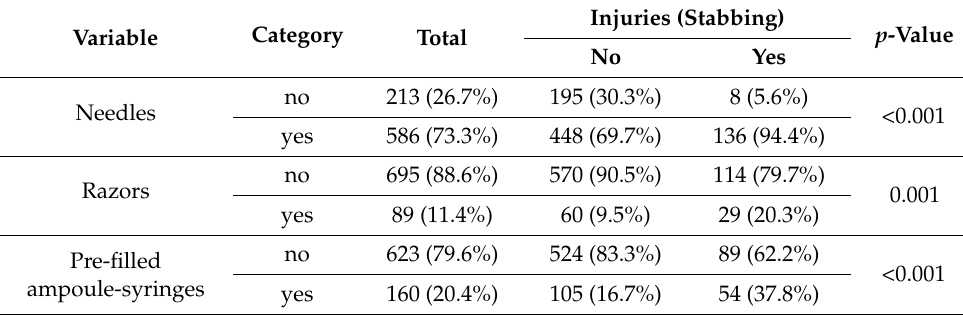
Table 2. Single-use sharp equipment and injuries while working with